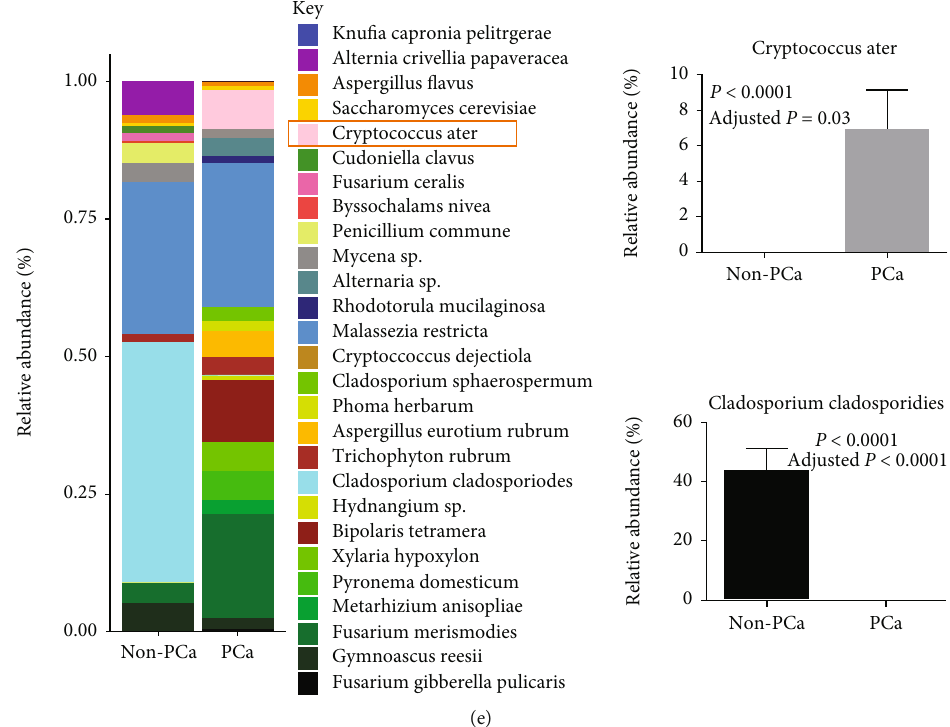
Figure 2: Plasma fungal microbiome in PCa patients and healthy men. (a) In the class level, enrichment of Sordariomycetes was increased in the PCa group ( P = 0 : 006 ) and enrichment of Dothideomycetes ( P = 0 : 003 ) was decreased in PCa patients compared to healthy controls. (b) Order Capnodiales was enriched in healthy controls compared to patients ( P < 0 : 0001 ). (c) Family Filobasidiales and Pyronemataceae ( P < 0 : 001 ) were enriched in PCa patients, and family Cladosporiaceae was reduced in PCa patients compared to controls ( P < 0 : 001 ). (d) Genus Cladosporium was enriched in healthy controls compared to patients ( P < 0 : 001 ). (e) Species Cryptococcus ater level was enriched in PCa patients compared to controls ( P < 0 : 0001 ), and species Cladosporium cladosporioides was enriched in healthy controls compared to patients ( P < 0 : 0001